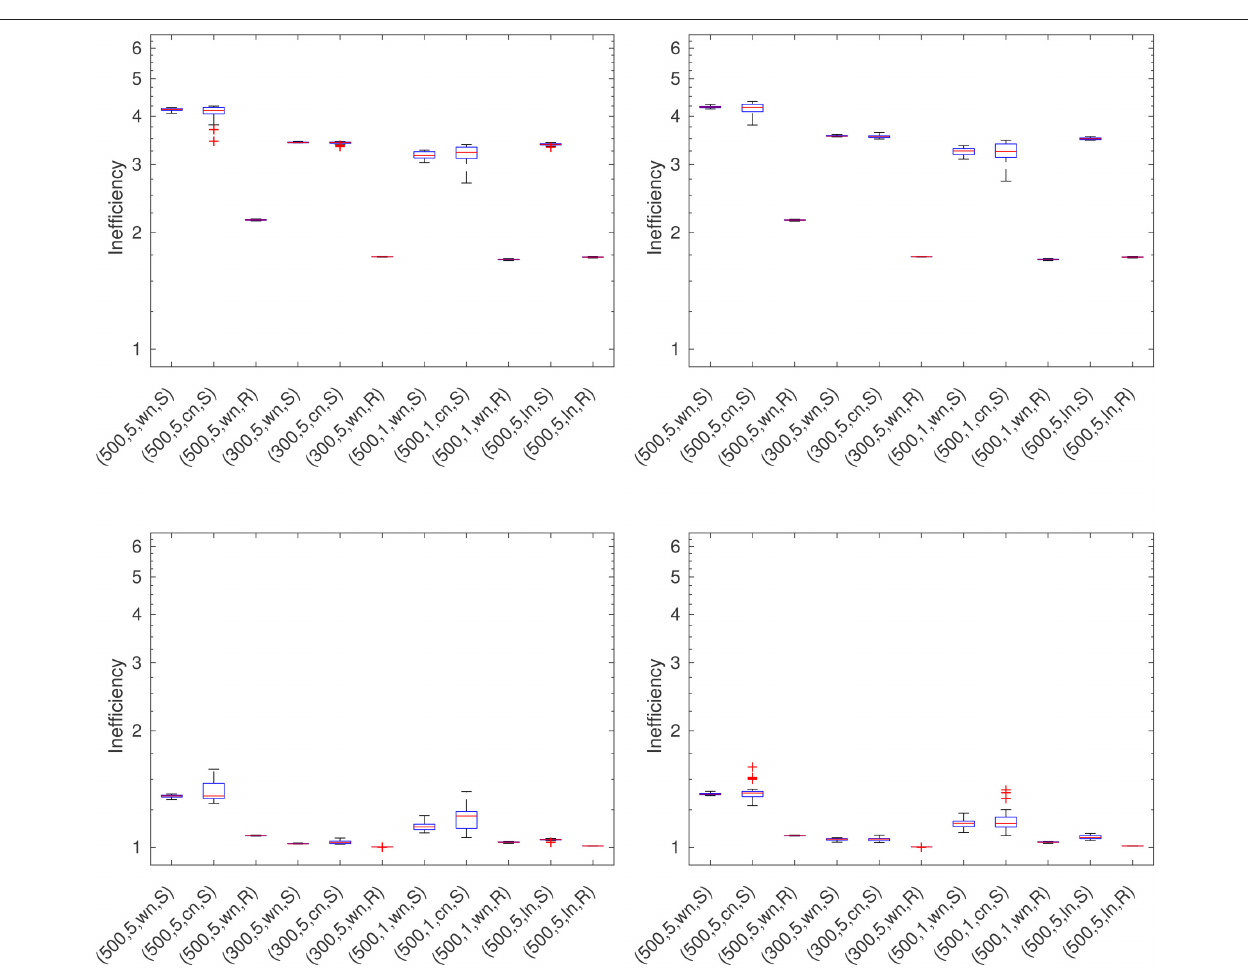
FIGURE 7 | GML for the RFMP (Left-hand top) and the ROFMP (Right-hand top) and GCV for the RFMP (Left-hand bottom) and the ROFMP (Right-hand bottom) .